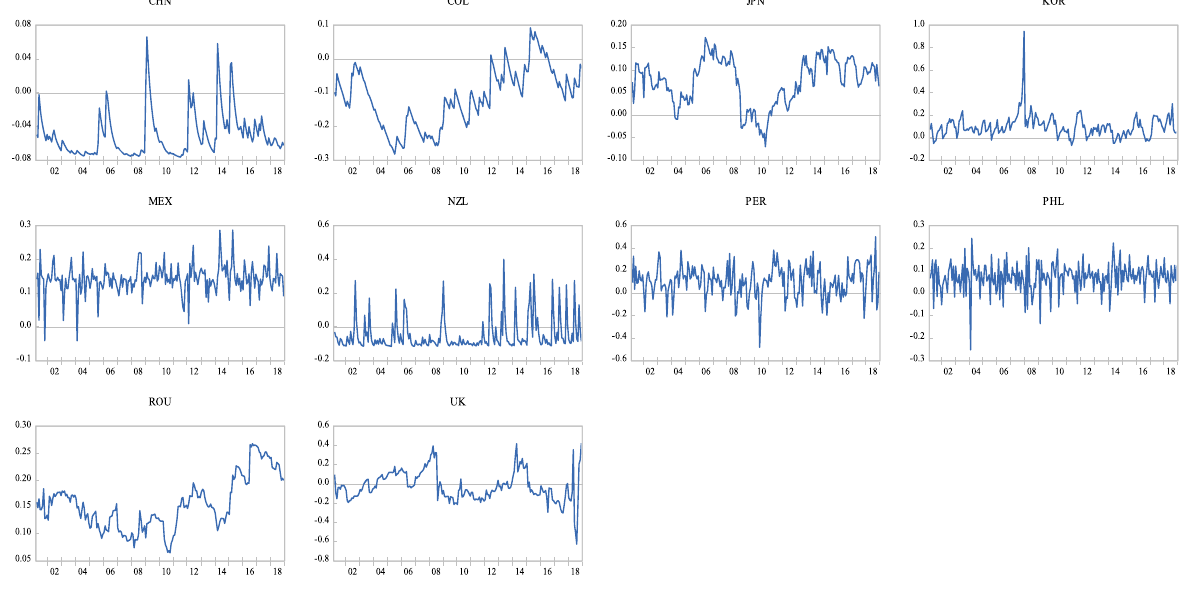
Fig. 2 Plots of dynamic correlation between global and local pork prices.